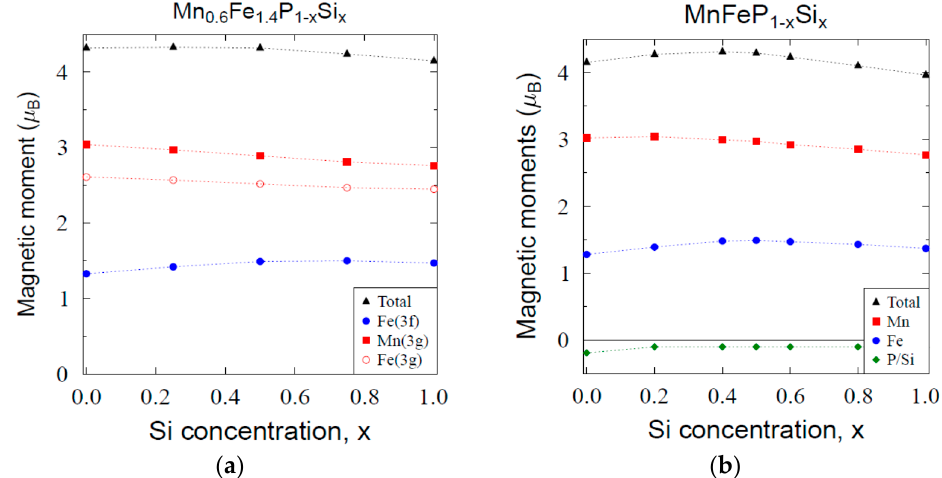
Figure 15. Magnetic moments versus Si concentration in ( a ) Mn 0.6 Fe 1.4 P 1 − x Si x and ( b ) MnFeP 1 − x Si x .